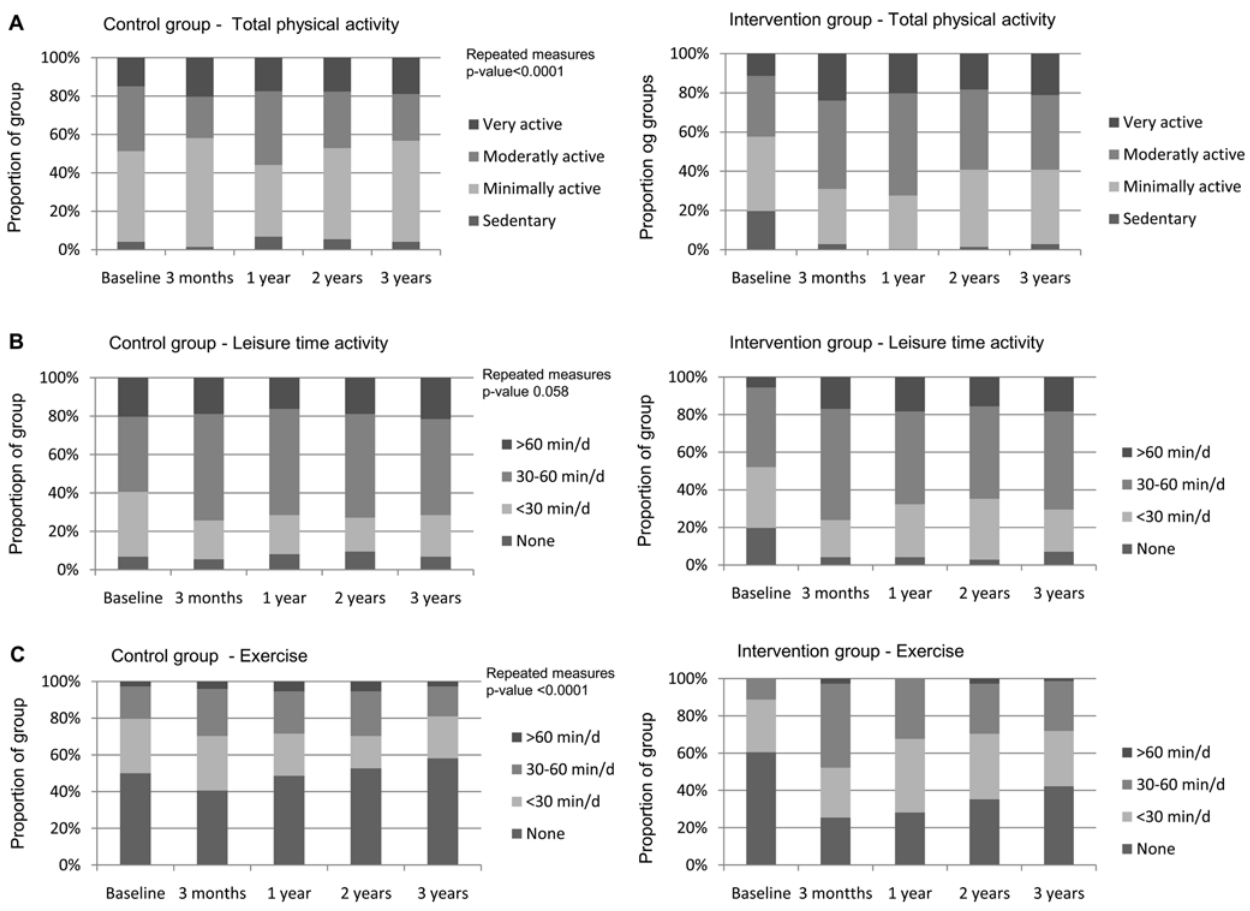
Figure 5. (A–C) Changes in physical activity level. Proportion of participants reporting the level of each variable, total physical activity, leisure time physical activity and exercise and ordered as follows: TPA; sedentary, minimally active, moderately active and very active. LTPA and exercise; ‘none’=0, ‘ , 30 min/day’=1, ‘30–60 min/day’=2, and ‘ . 60 min/day’=3. P values from general linear model repeated measures analysis.